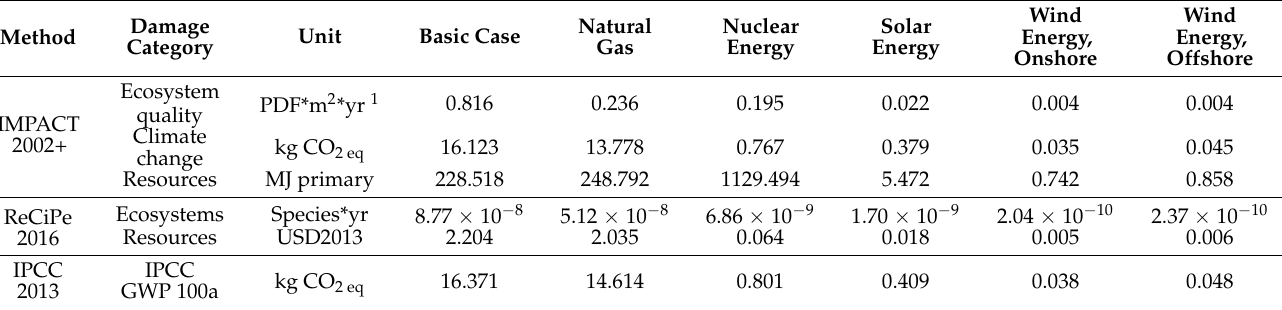
Table 12. Summary of impact assessment results for MSF used with different energy sources.